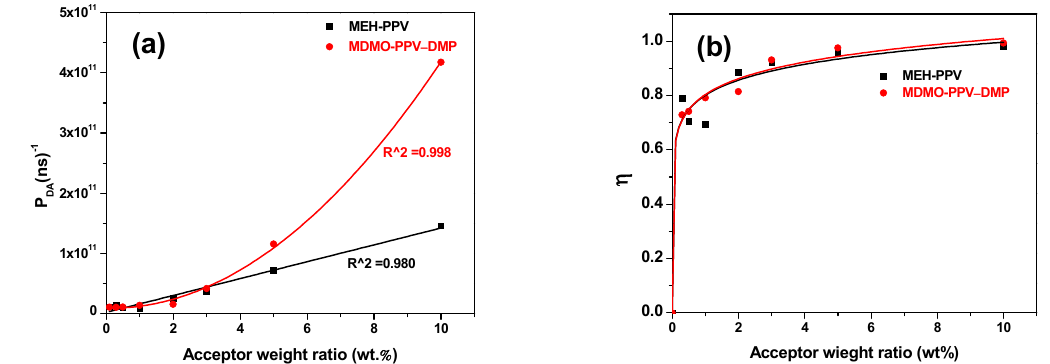
Figure 13. ( a ) Energy-transfer probability (P DA ) and ( b ) energy-transfer efficiency ( η ) from PFO to each MEH-PPV and MDMO-PPV–DMP. Solid curves refer to the fitting data.